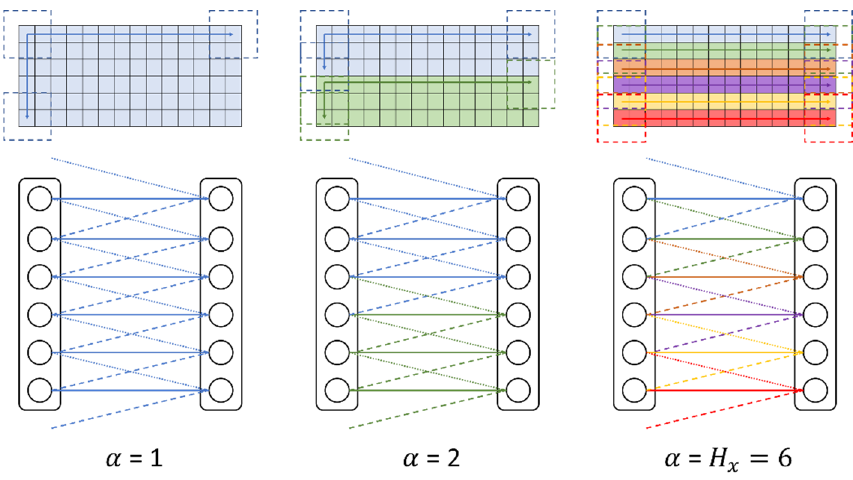
Figure 4. Semilocal